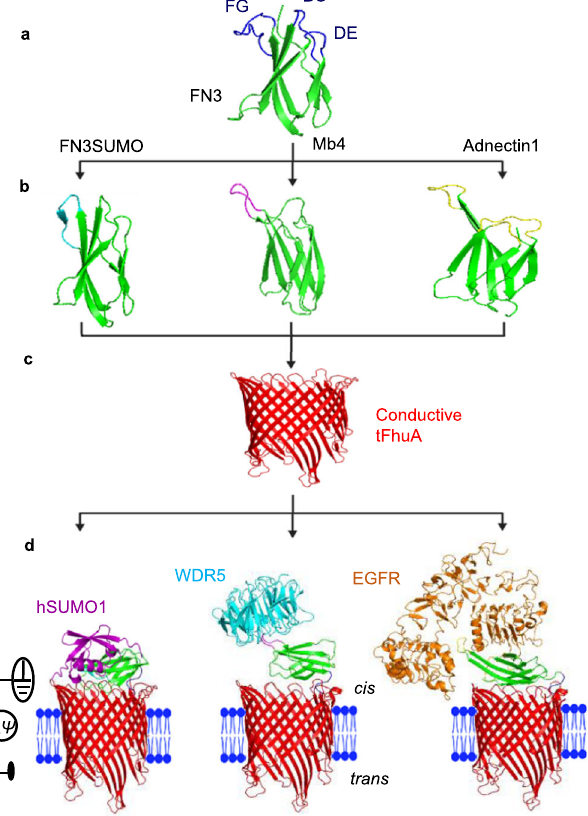
Fig. 1 | Rational protein design of a generalizable nanopore sensor for protein detection. a A tenth fi bronectin type-III domain (FN3) 34 or monobody (in green) with the FG, BC, and DE loops highlighted in blue. b The FN3 variants, where cyan, magenta, and yellow were used to represent the binding loops in FN3SUMO 45 , Mb4 46 , and Adnectin1 47 , respectively. c tFhuA (in red) 31 , a monomeric β barrel with averageinternaldiametersof~2.6and~3.9nm,asmeasuredfromsidechaintoside chain. d Functional reconstitution of nanopore sensors into a lipid bilayer. The hSUMO1-speci fi c nanopore is a single-polypeptide unit that comprises a tFhuA, a (GGS) 2 tether, and an FN3SUMO monobody (left). WDR5- and EGFR-binding monobodies, Mb4 (center ) and Adnectin1 (right), respectively, were also fused to tFhuA in the same way as FN3SUMO. hSUMO1, WDR5, and EGFR are marked in magenta, cyan, and brown, respectively. Δ ψ indicates the applied transmembrane potentialbetweenthe cis and trans sidesofthemembrane.Themonobody-analyte complexes are shown as well. The structures of all sensors were predicted by AlphaFold2 34,35